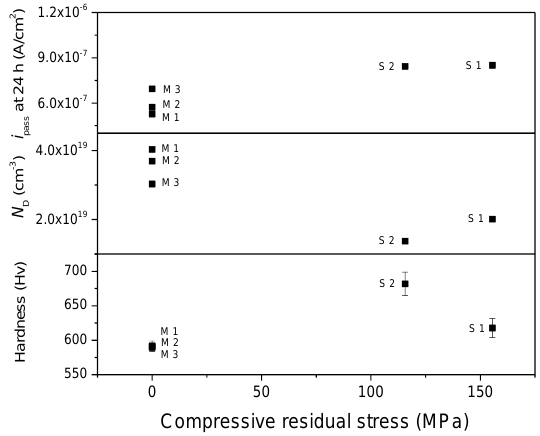
Figure 12. Effects of compressive residual stress on steady state passive current density, donor density, and hardness.